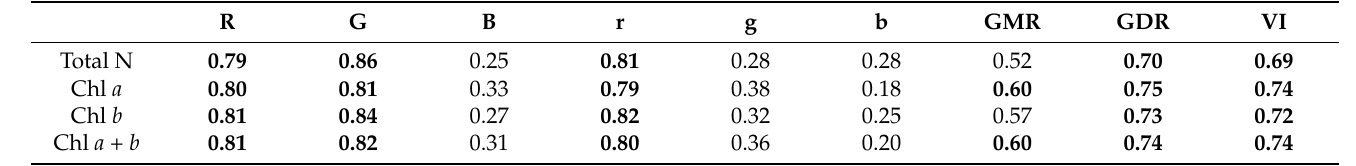
Table 2. Coefficients of determination (R 2 ) for the linear regression value between total N, Chl a , b and a + b and RGB values, rgb normalized values, and vegetation indices in P. obtusifolia . R G